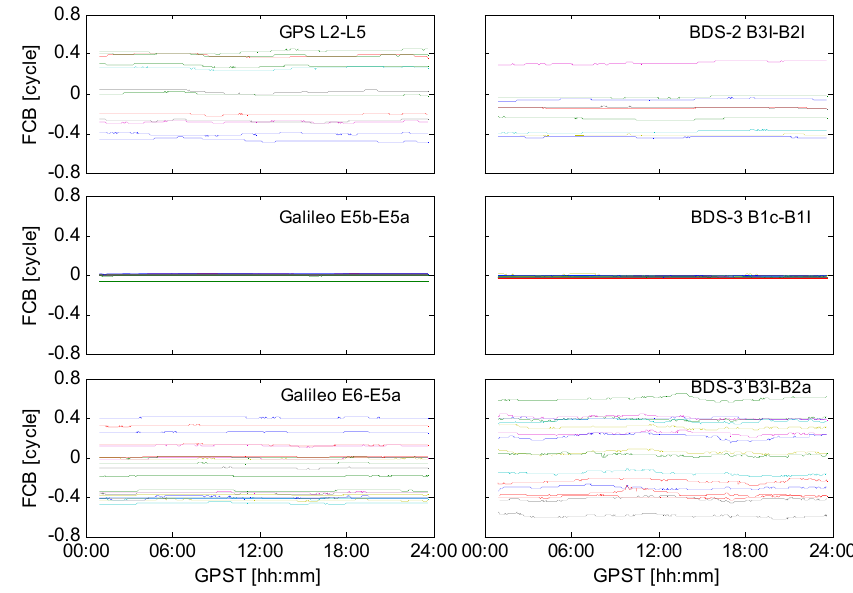
Remote Sens. 2021 , 13 , 3758 12 of 24